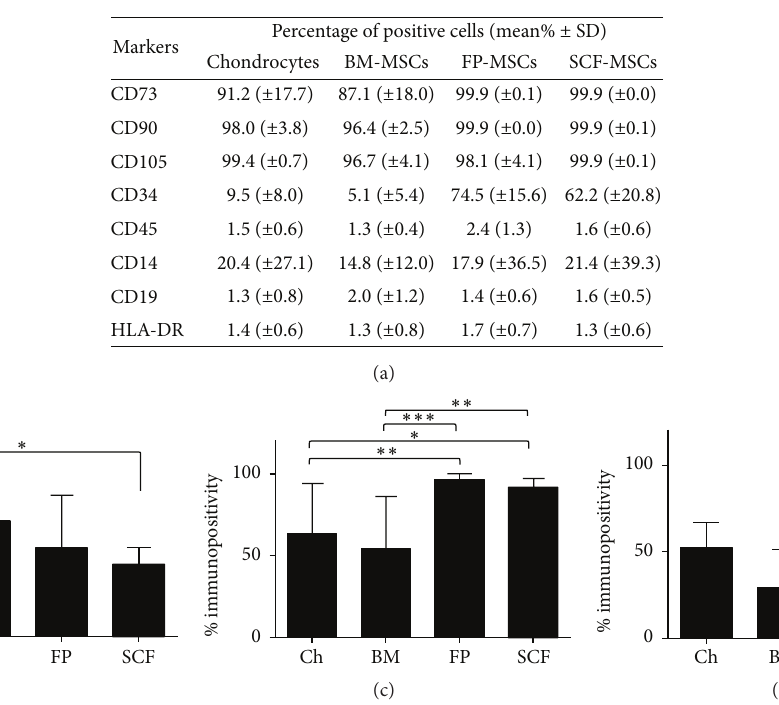
Figure 2: Immunoprofiles for MSC markers and putative chondrogenic potency markers of culture expanded cells prior to chondrogenesis. (a) ISCT MSC immunoprofiles. Immunoprofiles for the putative chondrogenic markers CD49c (b), CD166 (c), and CD39 (d). Flow cytometry was used to detect the percentage of positive cells for each marker on monolayer cell populations of chondrocytes (Ch), bone marrow MSC (BM), fat pad MSC (FP), and subcutaneous fat MSC (SCF) prior to chondrogenesis. Data shown are the means ± the standard deviation of 5 donors for each cell population. One-way ANOVA and post hoc Bonferroni tests were used to test for significant differences in the positivity of cell surface markers between cell